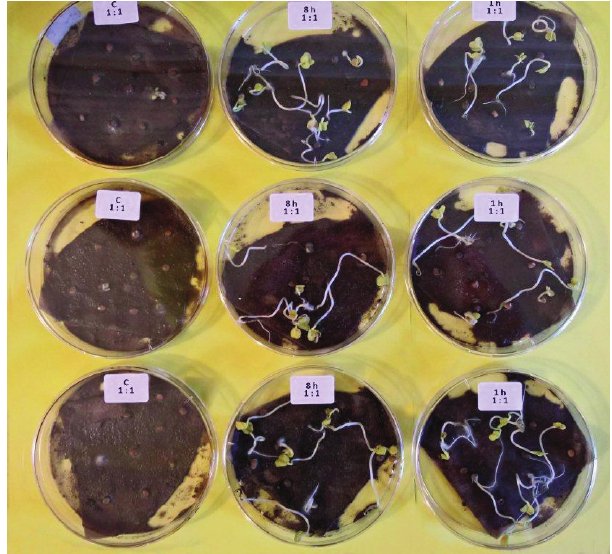
Fig. 1 - Radish seeds germination at T3; on the left, Petri dishes with untreated OOMW; in the middle, OOMW 8h; on the right, OOMW 1h (diluted 1:1